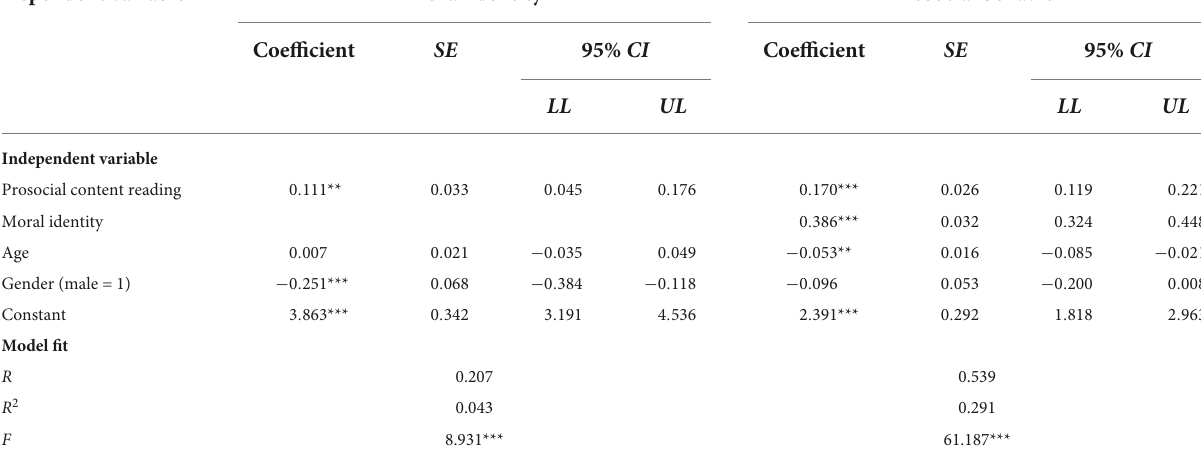
TABLE 2 Regression analysis